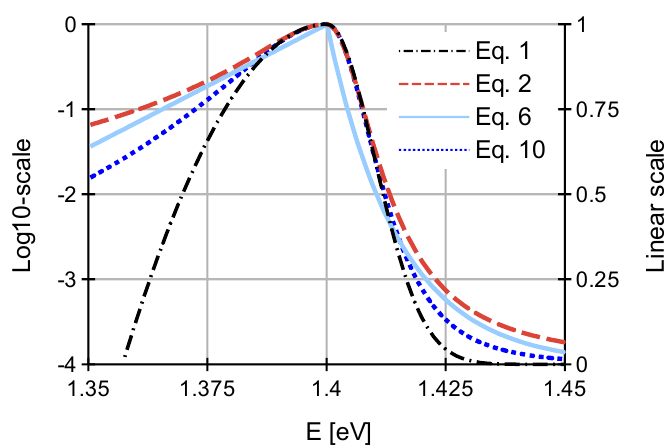
Figure 1. Comparison of four lineshapes: Equation (1): ( σ = 15 meV), Equation (2): ( τ = 50 fs), Equation (6): ( E u = 15 meV), Equation (10): ( τ be = τ bh = 35